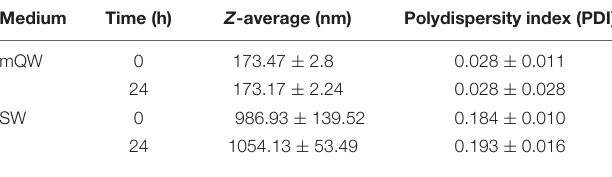
TABLE 2 | Mean ± SD of behavioural parameters of polystyrene nanoplastics (50 µ g ml − 1 ) suspended in Milli-Q (mQW) and filtered seawater (FSW) over 24 h.